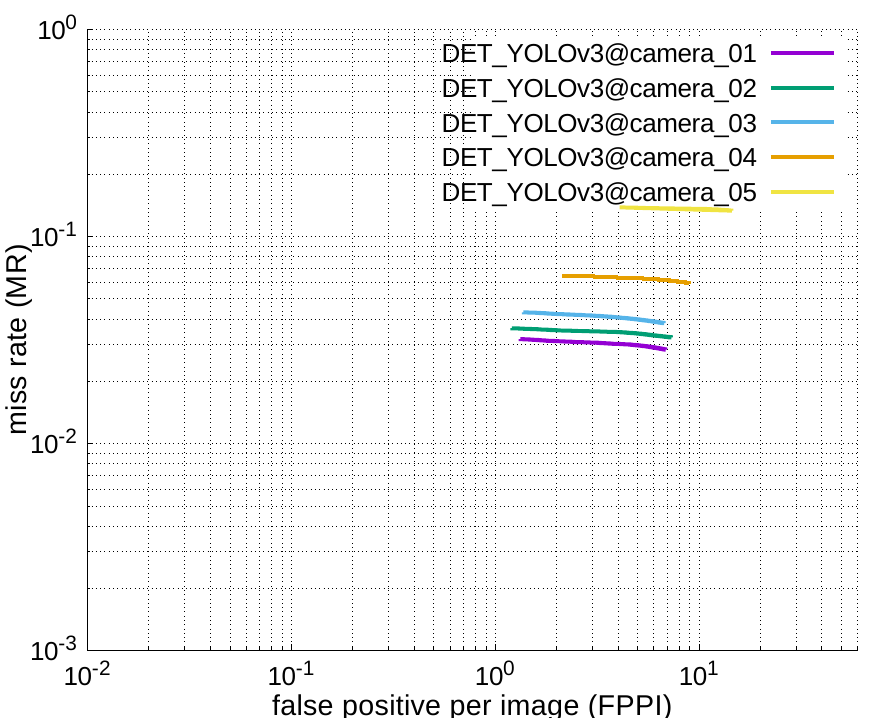
Figure 20. DET curve @ Camera_00, YOLOv3.